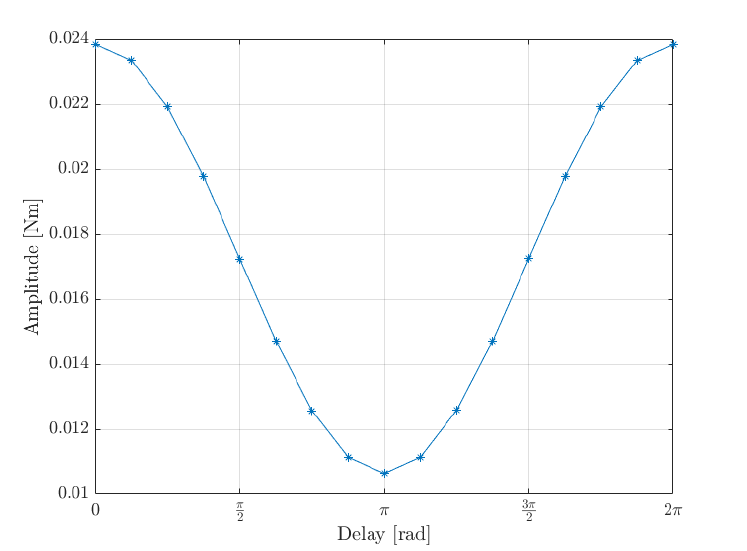
Figure 12. Simulated amplitude at first resonance frequency in the monitored torque at the load as a function of delay